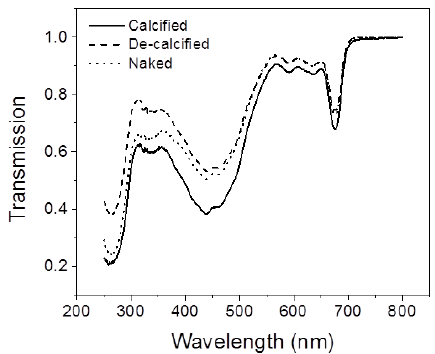
Figure 1. Transmission spectra of cells with (calcified strain) and without (calcified strain with coccoliths removed artificially, decal- cified strain) coccolith cover and naked cells of Emiliania huxleyi